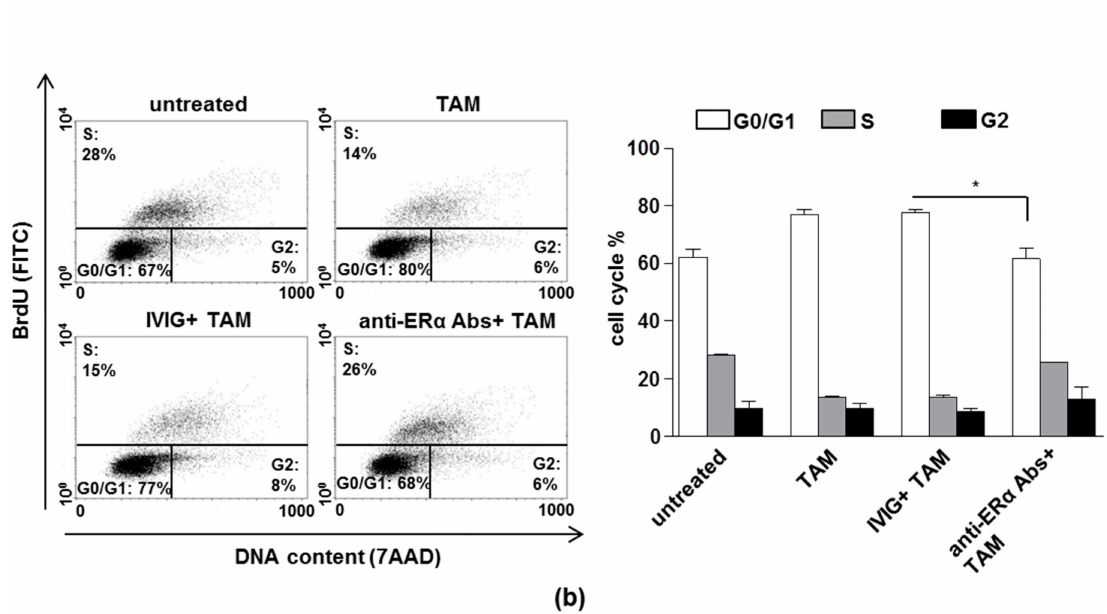
Figure 1. Anti-ER α Abs revert the e ff ect of tamoxifen (TAM) on cell proliferation and cell cycle. ( a ) Cell proliferation was evaluated by flow cytometry measuring Ki-67 nuclear antigen expression in MCF-7 cells treated or not for 24 h with intravenous immunoglobulin (IVIG) (50 µ g / mL), anti-ER α Abs (50 µ g / mL), TAM 1 µ M, IVIG (50 µ g / mL) plus TAM 1 µ M, anti-ER α Abs (50 µ g / mL) plus TAM 1 µ M. Results from one representative experiment out of five are shown (left). Data are also reported as mean ± SD (right), *, p < 0.05; **, p < 0.01 by Student’s t test. ( b ) Cell-cycle phases were determined by flow cytometry analysis of BrdU / 7AAD staining in synchronized MCF-7 cells treated or not for 24 h with TAM 1 µ M, IVIG (50 µ g / mL) plus TAM 1 µ M, anti-ER α Abs (50 µ g / mL) plus TAM 1 µ M. Results from one representative experiment out of five are shown. Data are also reported as mean ± SD of each phase. *, p < 0.05 by Student’s t